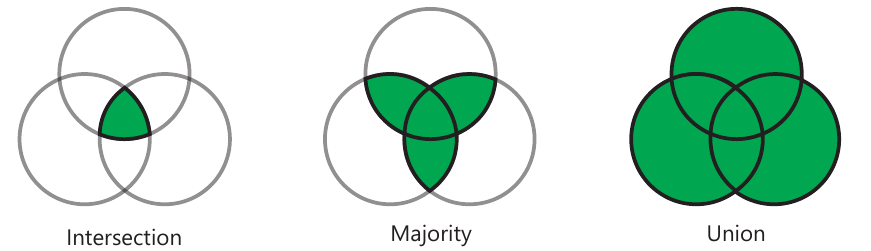
Figure 3. A schematic overview illustrating the 3 voting approaches. Each circle represents a tumor segmentation result by one model (3 models in total). Each voting method generates a white area, which is the predicted healthy area, and a green-shaded area, which is the predicted tumorous